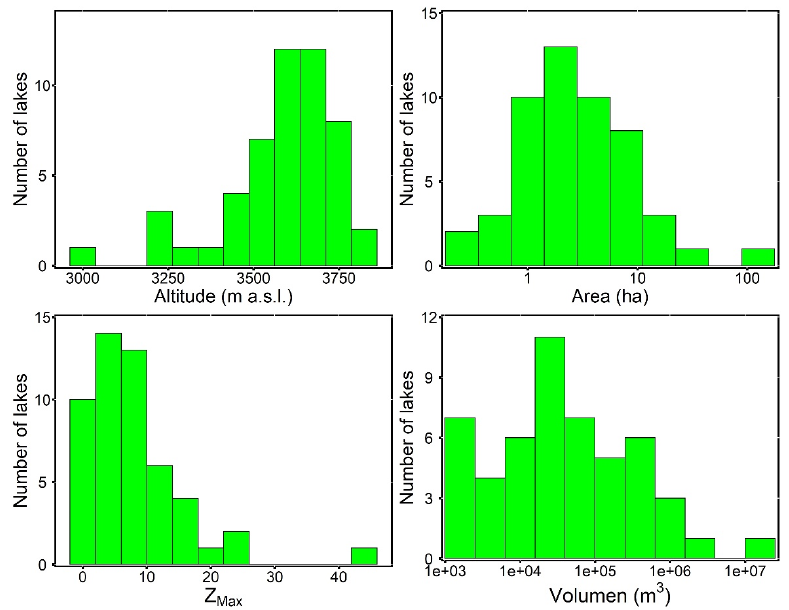
Water 2021 , 13 , x FOR PEER REVIEW Figure 3. Morphometry of the 51 lakes studied in the Eastern Cordillera of the Colombian Andes.